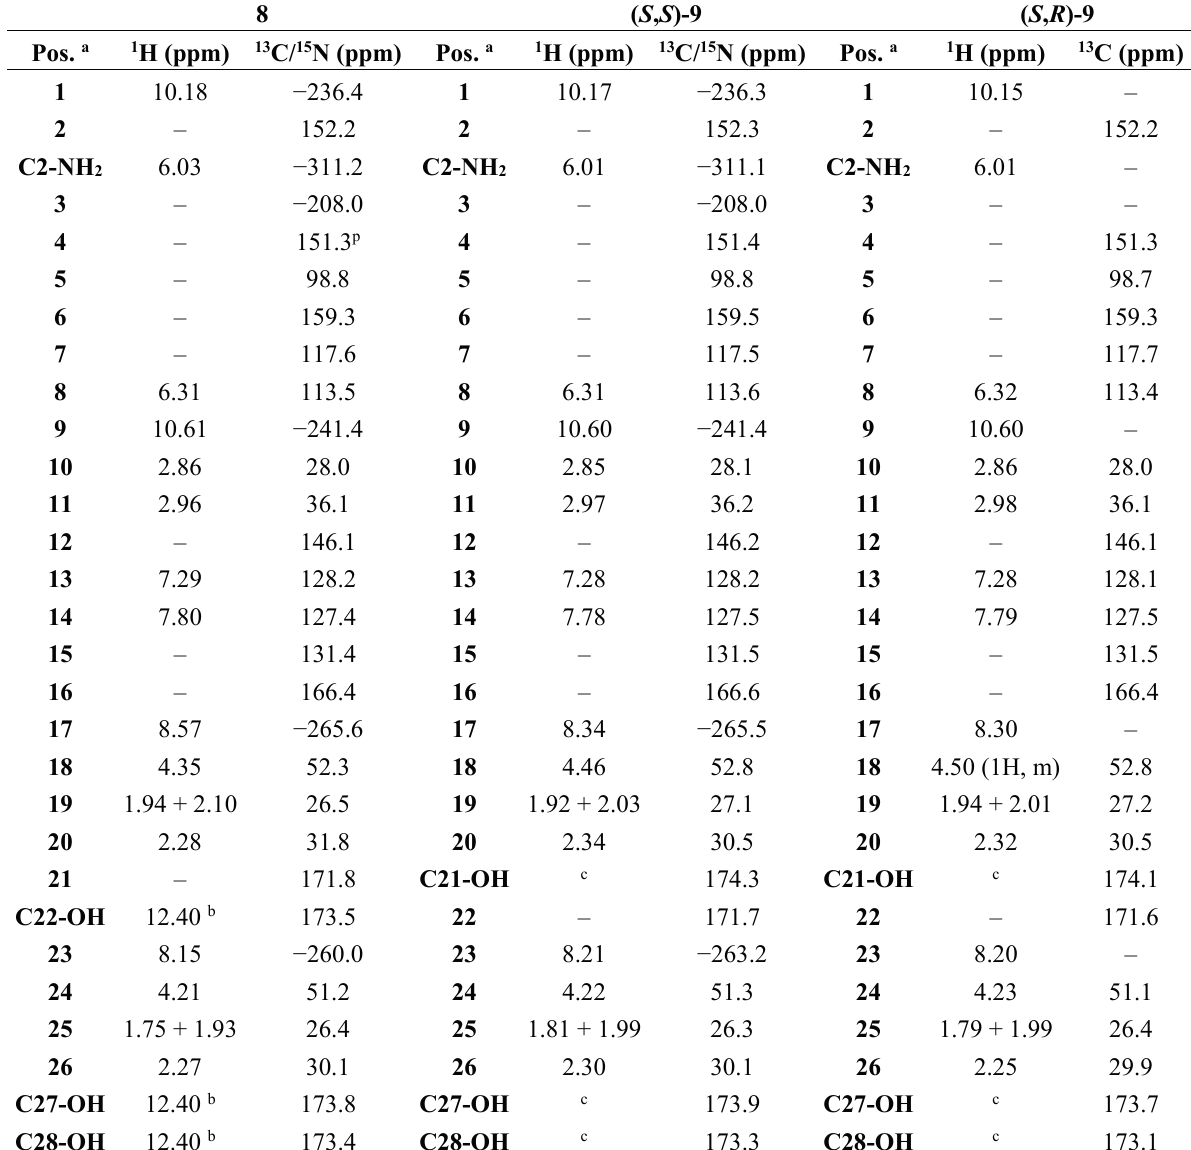
Table 3. NMR Data for compounds 8 , ( S , S ) -9 and ( S , R ) -9 with the correlations observed in the HSQC and HMBC spectra. 8 ( S , S )-9 ( S , R )-9 Pos. a